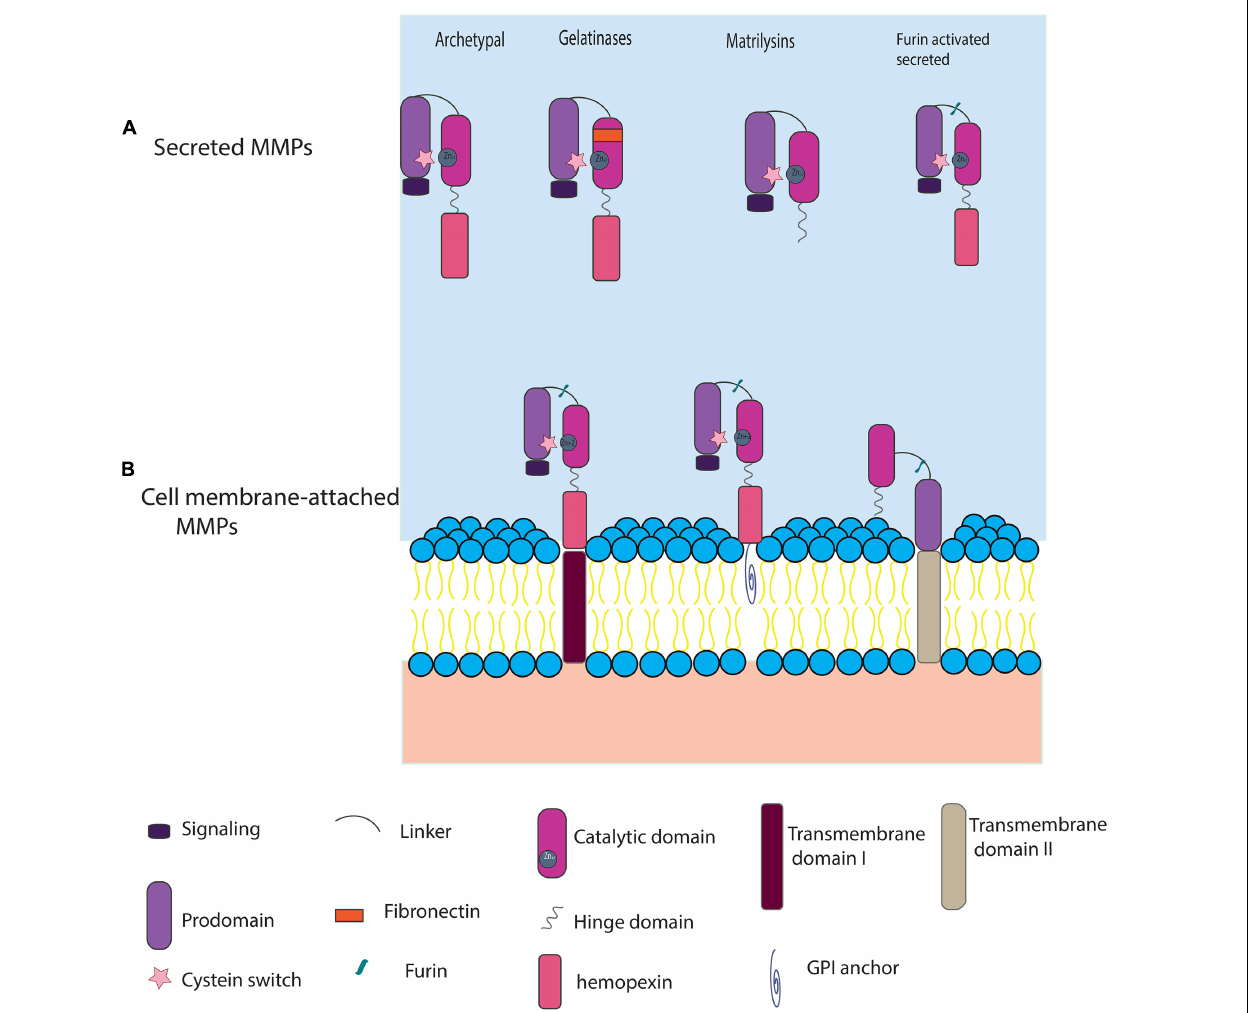
FIGURE 1 | A generic classification of MMPs using protein domain structure. (A) Secreted MMPs: include archetypal MMPs [collagenases and stromelysins, and four others (MMP1, 13, 8, 3, 10, 12, 19, 20, 27), two gelatinases (MMP2, 9), Matrilysins (MMP7, 26), and the furin-activated stromelysins (MMP11, 21, 28)]. (B) Cell membrane-attached MMPs include additional domains like: transmembrane type I domain (MMP14, 15, 16, 24), GPI anchor (MMP17, 25), and transmembrane domain II (MMP23A, MMP23B). Furin-activated MMPs typically lose their pro-peptide domain before docking on the cell membrane, but for simplicity we show them in the pre-digested